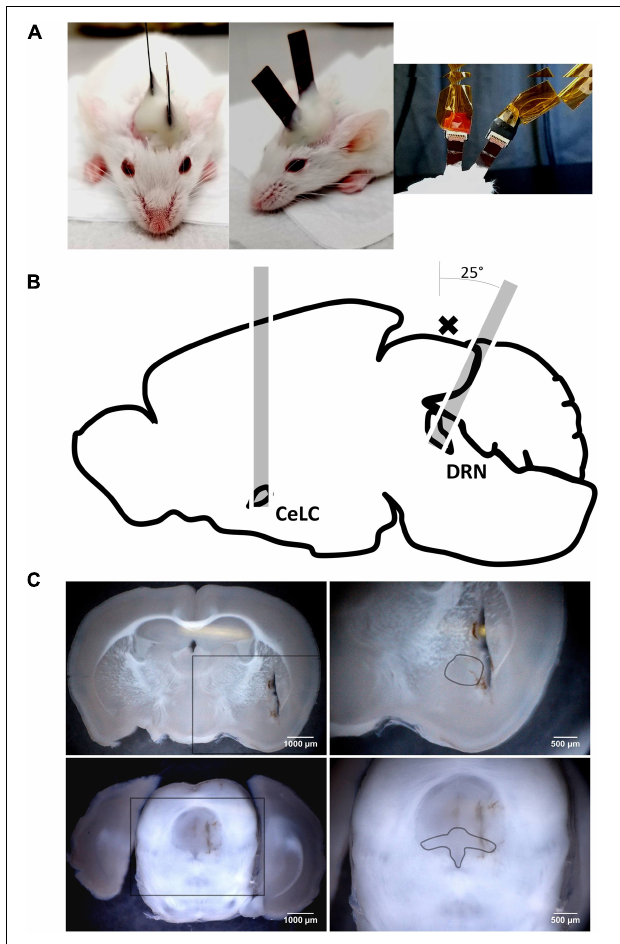
FIGURE 2 | The implanted mouse and the paths of the implants to their targets. (A) Left and Middle: A mouse that has just underwent double-implantation, under anesthesia. Note the differing angles of the implanted devices; Right: Implanted devices attached to cables used for supplying power and collecting calcium-signaling fluorescence data. (B) Paths of implantation through the brain. The cross (x) indicates the location of a large superficial transverse blood vessel on the brain’s surface. (C) Coronal sections depicting lesions from implantations and the loci of the brain site targets. Lesions do not reach the dorsal brain surface because the sectioning and the implantation planes are not parallel, more so for the DRN targeting. Upper Left: AP: –1.58 mm, 25 × ; Upper Right: Zoomed in section from rectangle in upper left image, dashed line approximates the perimeter of the central amygdala (CeA), 45 × ; Lower Left: AP: –4.36 mm, 25 × ; Lower Right: Zoomed in section from rectangle in lower left image, dashed line approximates the perimeter of the DRN (dorsal, ventral, and lateral subsections), 45 ×